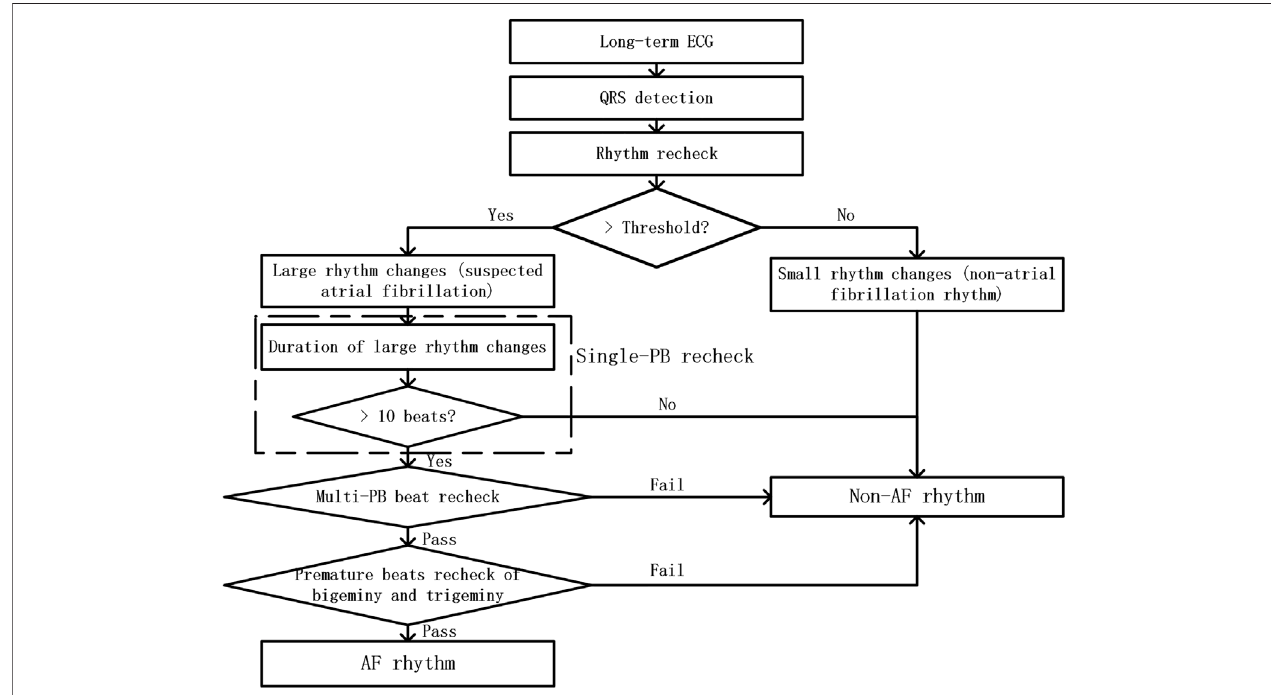
FIGURE 2 | The fl ow chart of RR-interval based premature rhythms elimination method from PAF detection